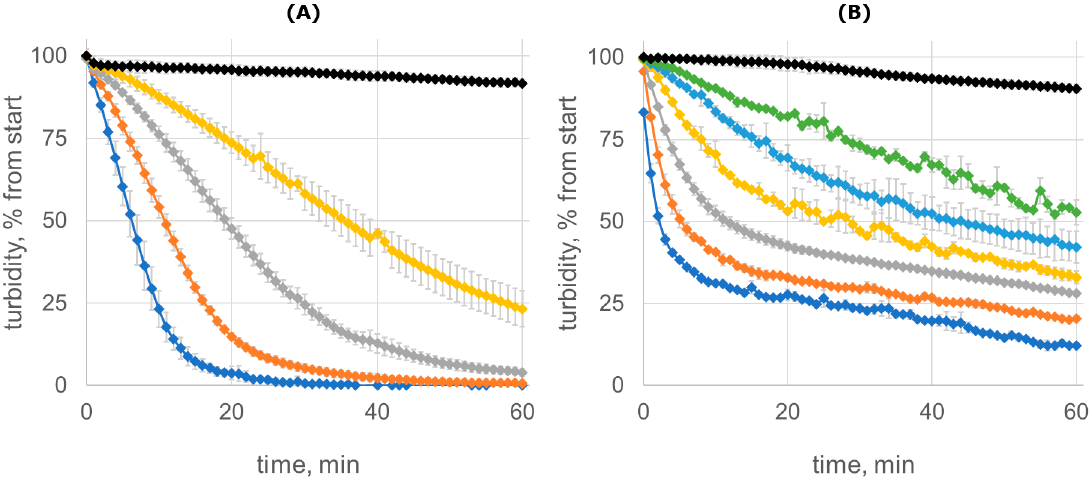
Figure 3. Clearing of S. aureus ATCC 29,213 cell suspension due to different concentrations of lysostaphin ( A ) or Lst-HDD ( B ). Lysostaphin concentrations are 2 µg/mL (blue), 1 µg/mL (orange), 0.5 µg/mL (grey), 0.25 µg/mL (yellow), and control without lysostaphin (black); Lst-HDD concentrations are 12 µg/mL (blue), 6 µg/mL (orange), 3 µg/mL (grey), 1.5 µg/mL (yellow), 0.75 µg/mL (light blue), 0.38 µg/mL (green), and control without Lst-HDD (black). The mean values of n = 3 (lysostaphin) or n = 2 (Lst-HDD) experiments are shown, error bars represent standard deviation.